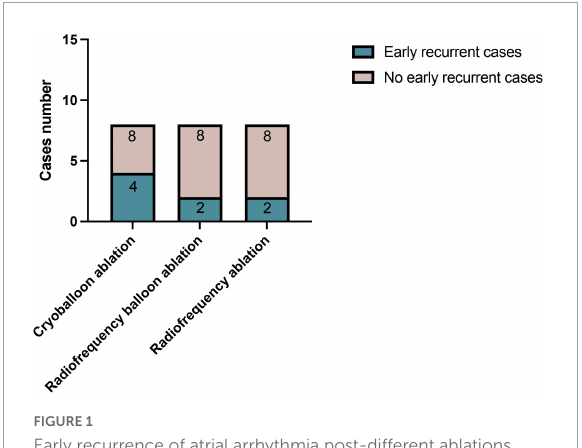
FIGURE1 Early recurrence of atrial arrhythmia post-different ablations during hospitalization. The early recurrent cases of atrial arrhythmia post-ablations were not significantly different between three ablation groups ( p =